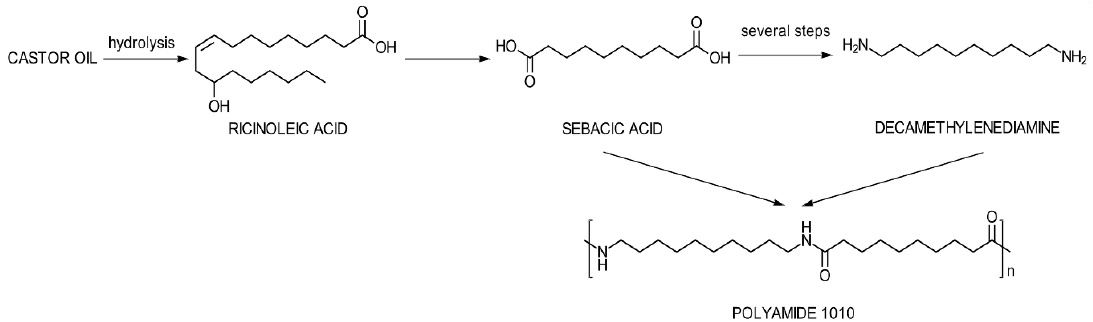
Figure 1. Simplified scheme for the synthesis route of bio-based PA1010 from castor oil.